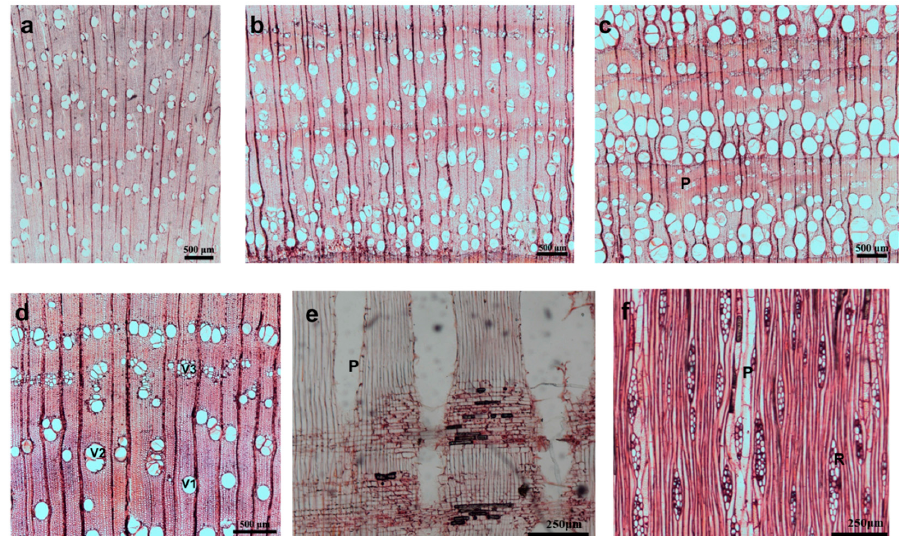
Figure 2. Sections of xylem in C . bungei in 1-1: ( a ) between the age of 1 and 2 years, wood was diffuse-porous; ( b ) between the age of 3 and 9 years, wood was semi-ring-porous, ring width was approximately 5 mm, and the latewood percentage was 80%; ( c ) between the age of 10 and 13 years, wood was ring-porous, ring width was approximately 2 mm, and the latewood percentage was